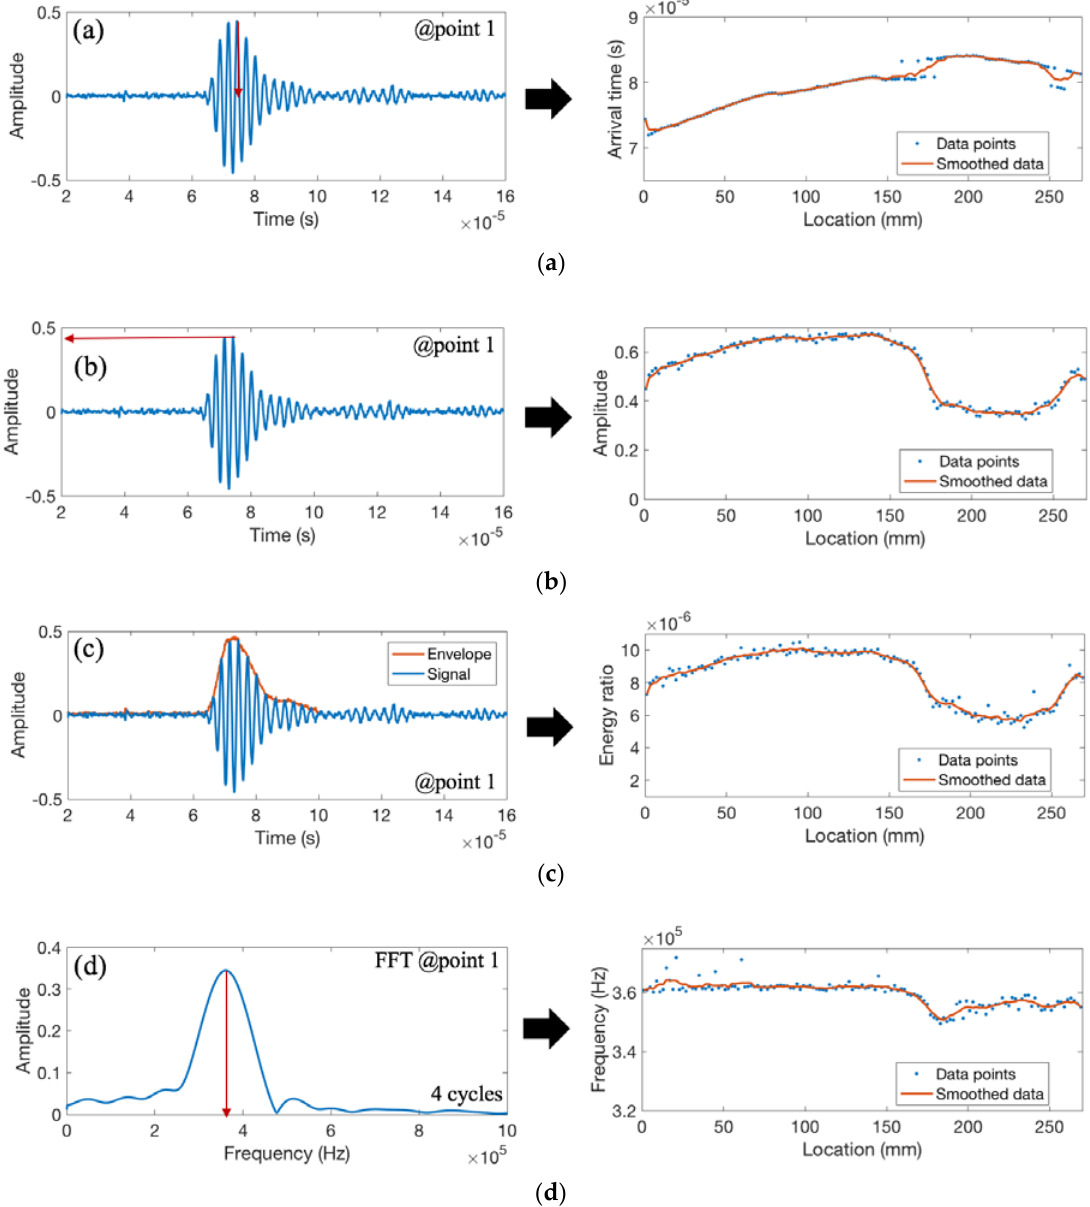
Figure 11. The recorded waveform and features extracted from weld coupon No. 2 corresponding to ( a ) the arrival time of the peak amplitude; ( b ) the peak amplitude; ( c ) the area under the envelope of the first arrived waveform; and ( d ) the peak frequency.